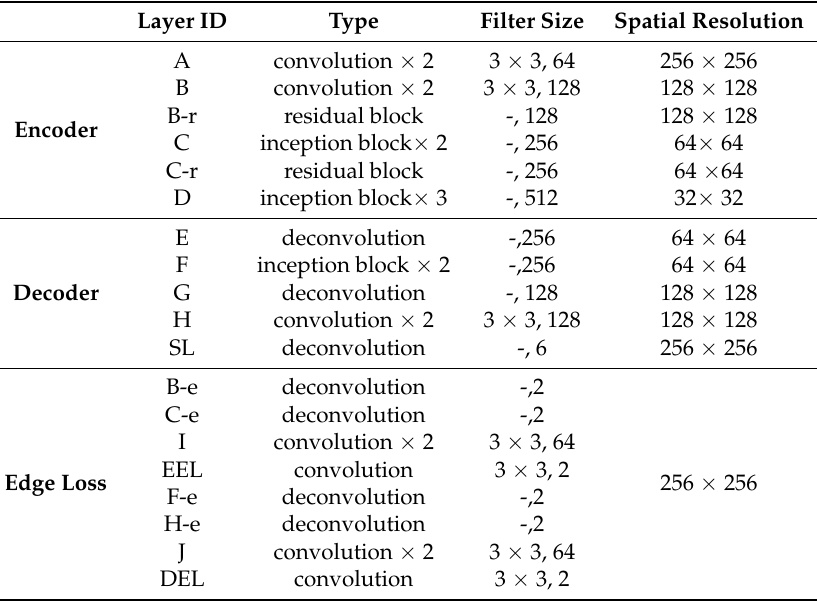
Table 1. Configurations of the